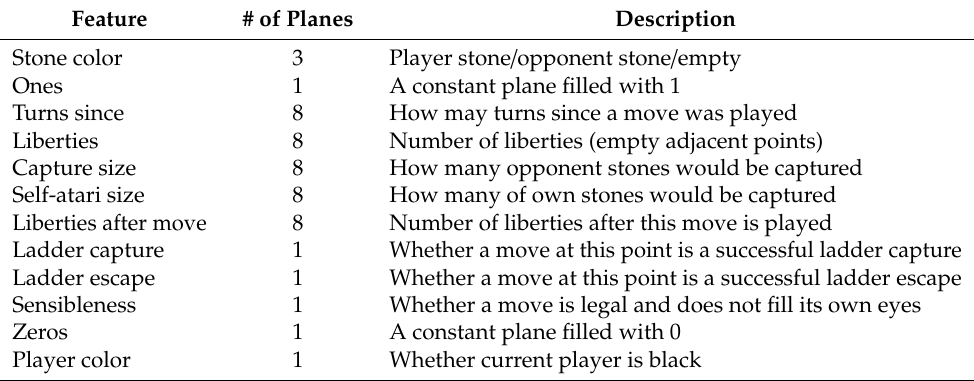
Table 1. Input features for neural networks in